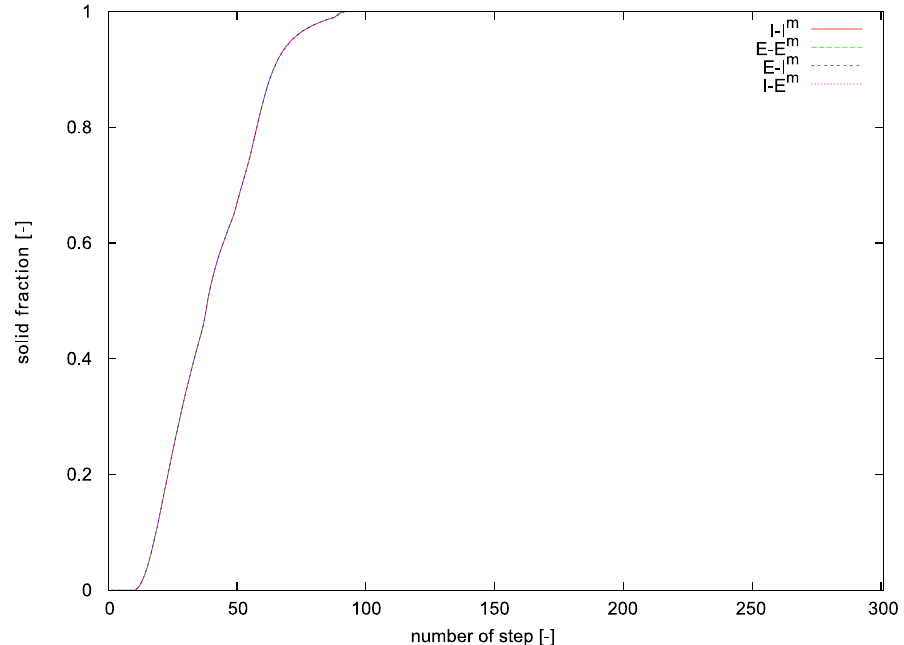
Figure 8. Cooling curves obtained for selected point in casting domain. Temperature distribution for multiplication factor m = 1 calculated by mixed time partitioning methods.